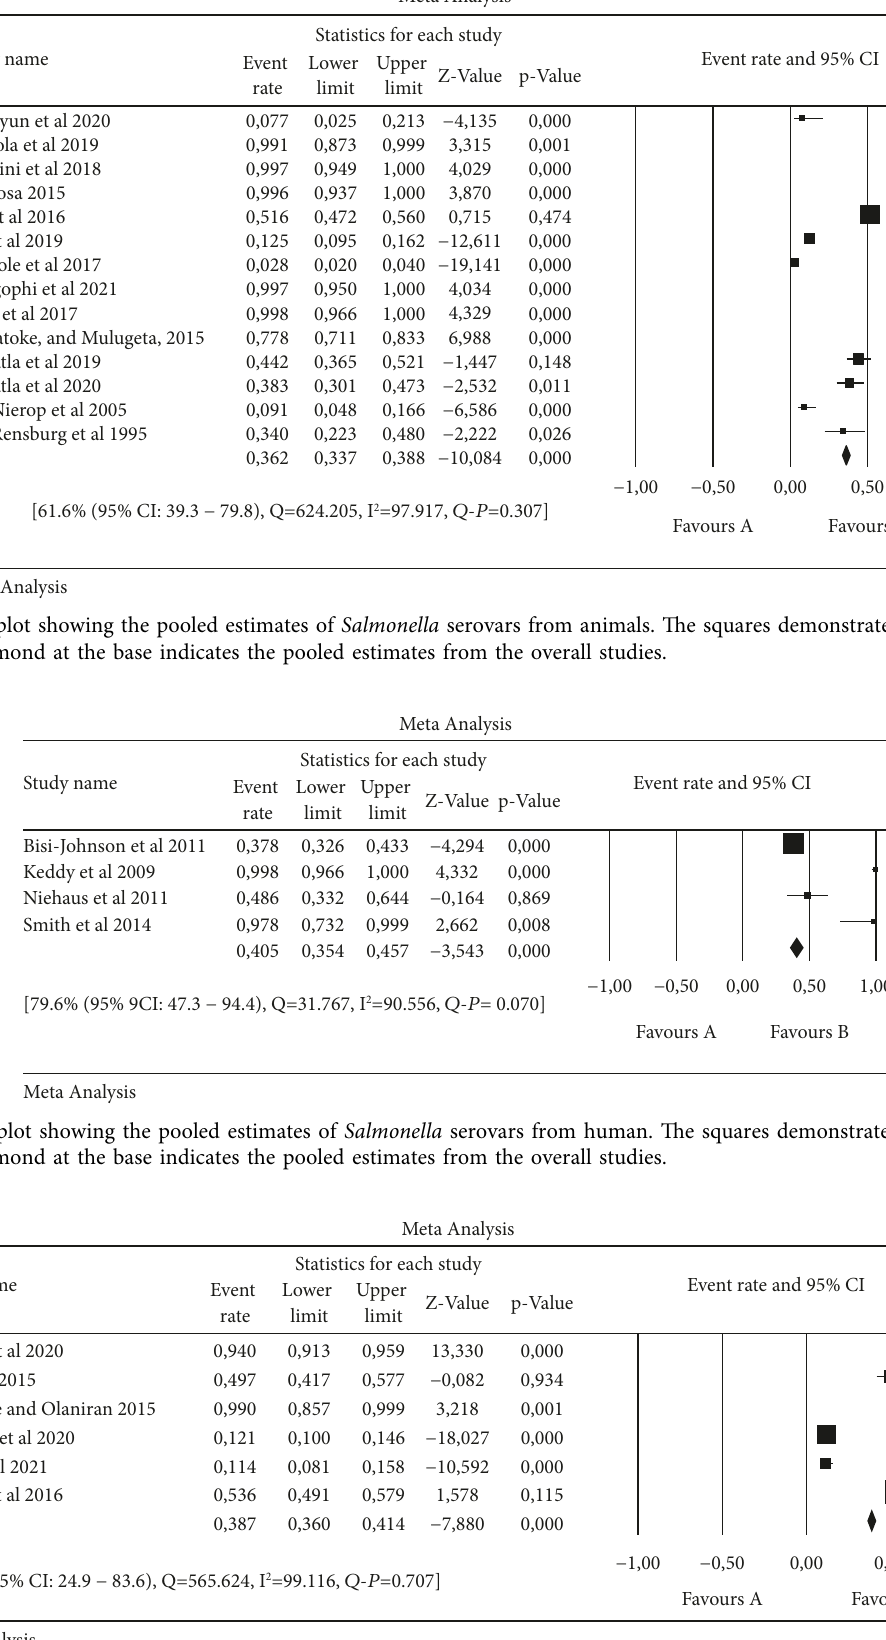
Figure 4: Forest plot showing the pooled estimates of Salmonella serovars from environment. The squares demonstrate the individual point estimate. The diamond at the base indicates the pooled estimates from the overall